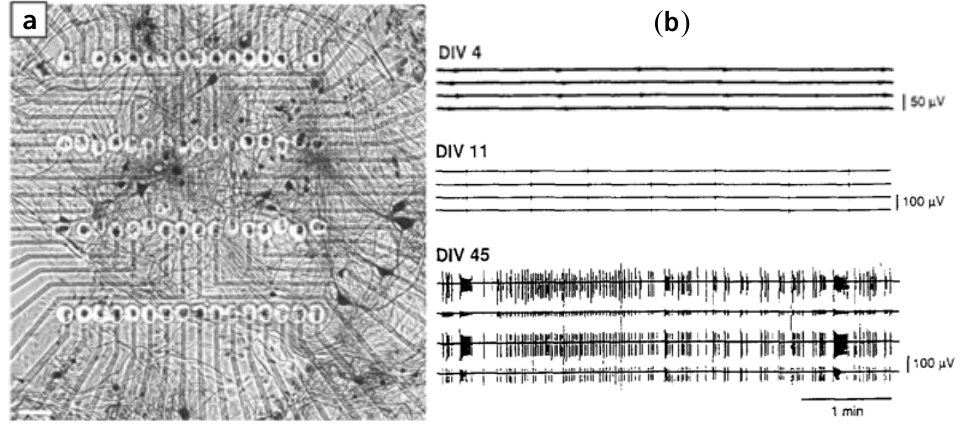
Figure 13. ( a ) Neuronal network derived from murine spinal cord tissue (92 days in vitro ), grown on the recording matrix of a 64-electrode array plate. (Reprinted from [70]. ©2007, with permission from Elsevier) ( b ) Developmental changes in neuronal activity.